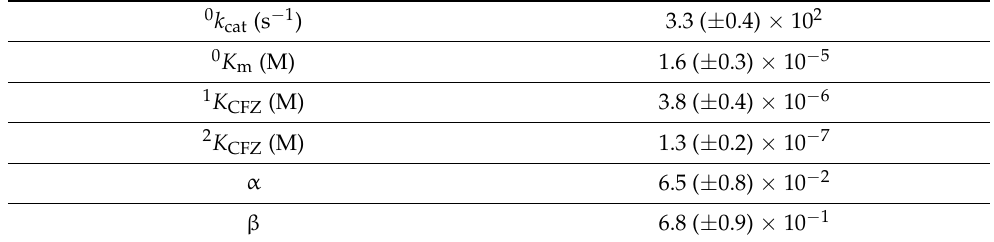
Table 3. Kinetics parameters of CFZ binding to